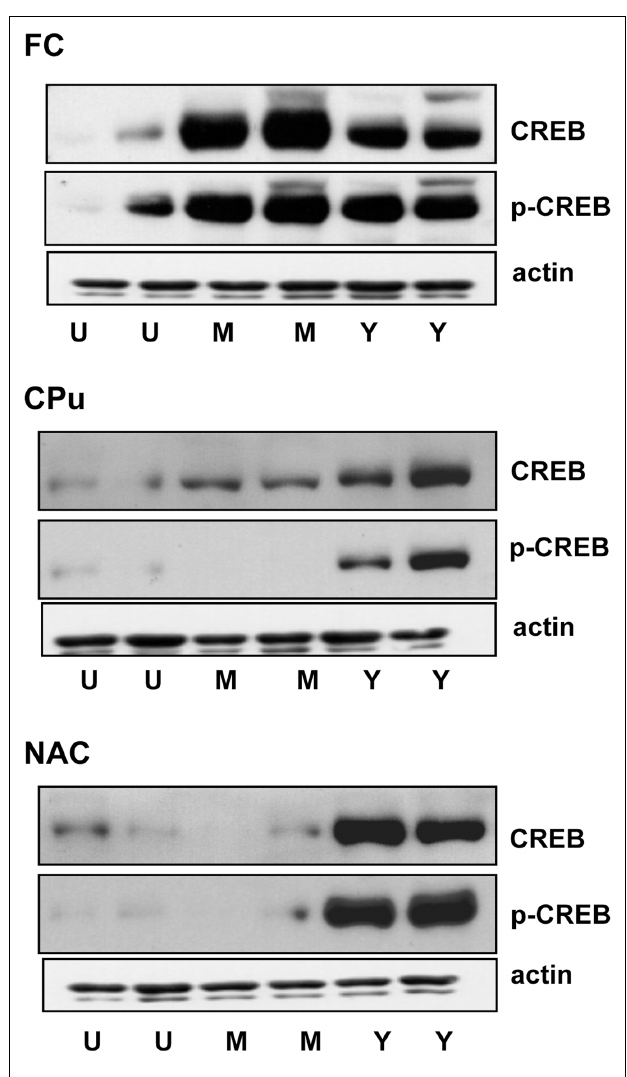
FIGURE 3 | Immunoblots of p-CREB, CREB, and actin in the frontal cortex (FC) Caudate–putamen (CPu) and nucleus accumbens (NAC) of representative untrained (U), master (M), and yoked (Y) rats. Blots were obtained from the same gel.